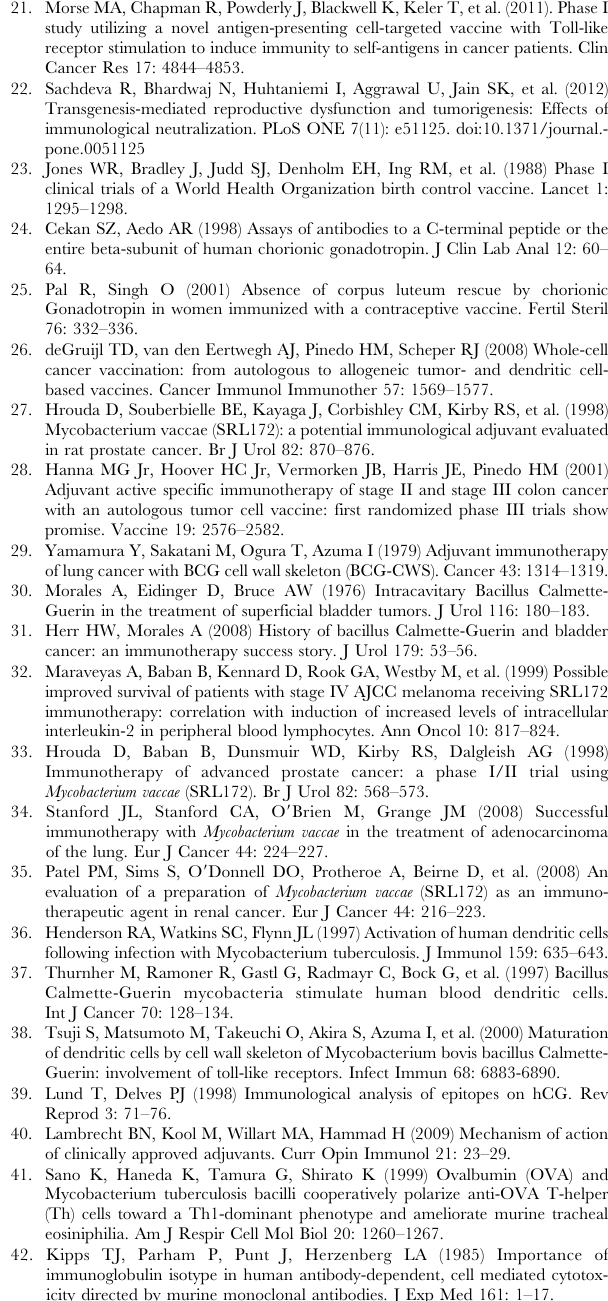
Figure S1 Evaluation of BALB/c x FVB/J b hCG/- F1 mice. (A) Detection of the b hCG transgene by PCR on genomic